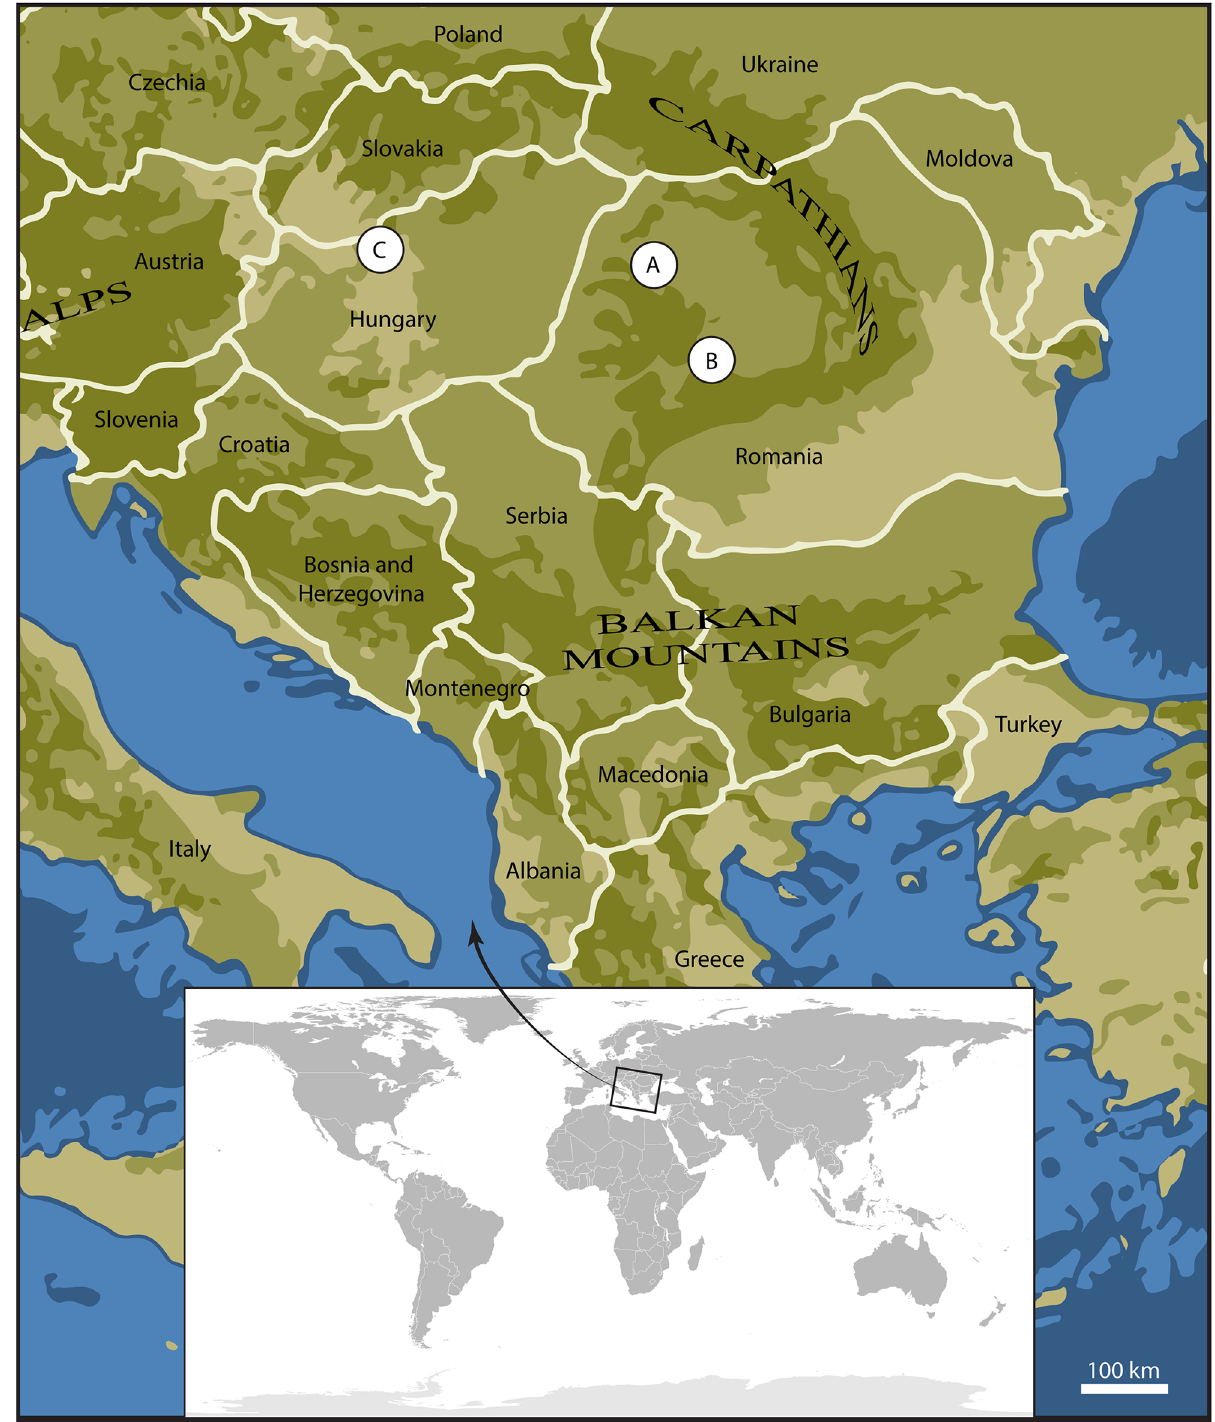
Fig 1. Geographical setting of the new amynodontid localities in Eastern Europe. A: Morlaca (Romania), Priabonian. B: Dobaˆrca (Romania), Priabonian-Rupelian. C: Dorog (Hungary), late Lutetian-Bartonian.